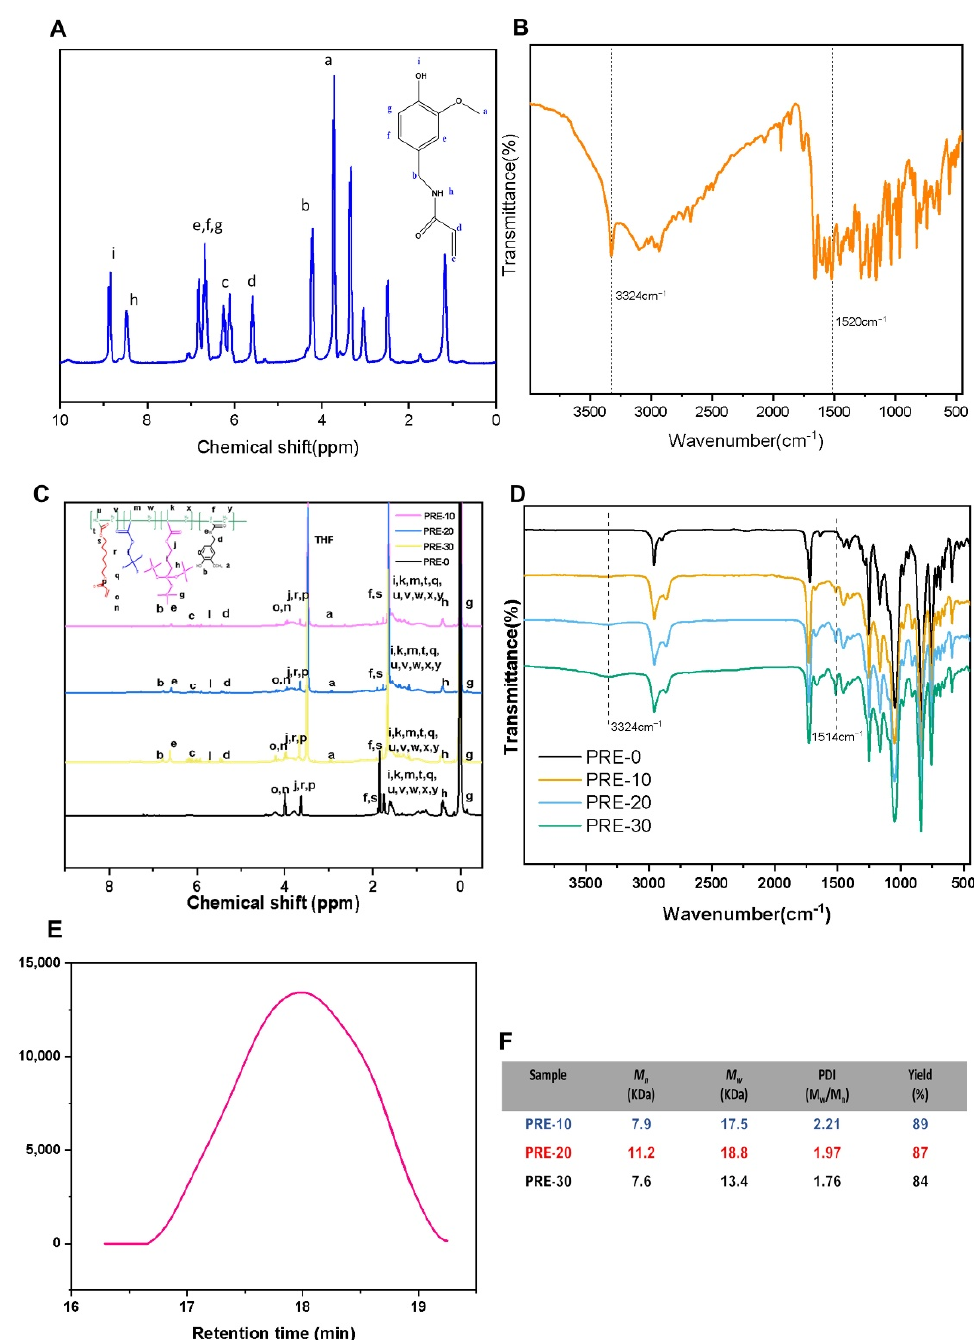
Figure 2. The structure of PRE polymer ( A ) 1 H NMR of HMBA, ( B ) FTIR spectrum of HMBA, ( C ) 1 H NMR of PRE polymer, ( D ) FTIR spectrum of PRE polymer, ( E ) Gel permeation chromatography of PRE-0, ( F ) Molecular weight and polydispersity and yield of the polymer. Gel permeation chromatography (GPC) analysis revealed the molecular weight (Mw = 13.4–18.8 kDa) and narrow polydispersity (PDI = 1.76–2.21) of the PRE